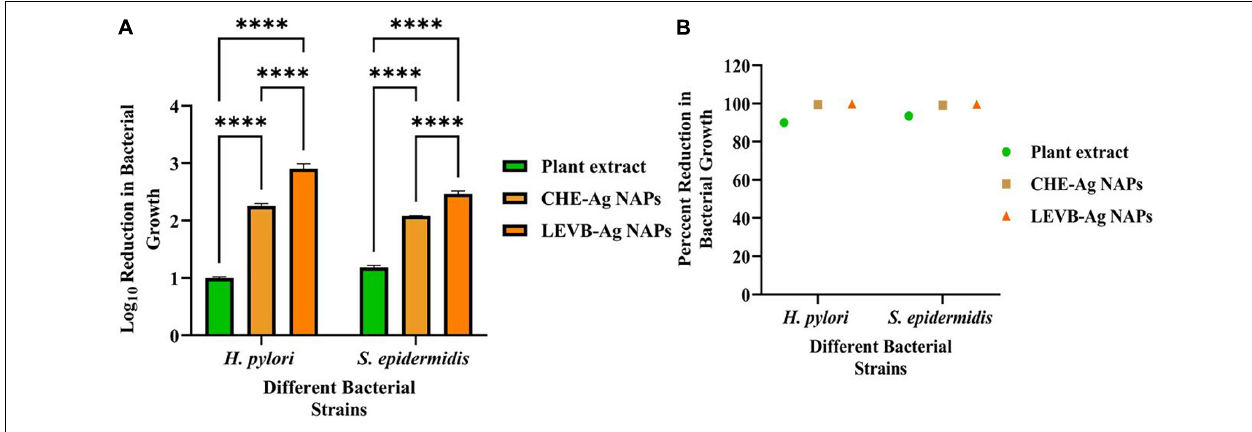
FIGURE 3 | (A) Log10 reduction and (B) percent reduction in bacterial growth of Gram-positive and Gram-negative bacterial strains demonstrated by LEVB-Ag NAPs in comparison to plant leaf extract and CHE-Ag NAPs (**** p <